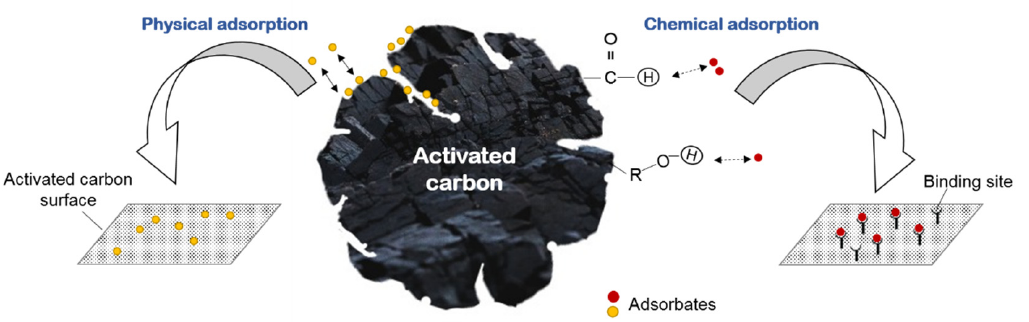
Figure 2. Interaction between activated carbon surface (adsorbent) and adsorbate molecules by physical and chemical adsorption.